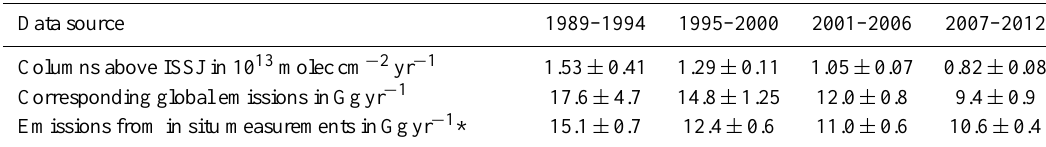
Table 2. Discrete six-year time averaged CF 4 trends based on tangential derivatives to the black line of Fig. 2, and corresponding emissions at 1992.0, 1998.0, 2004.0, and 2010.0.